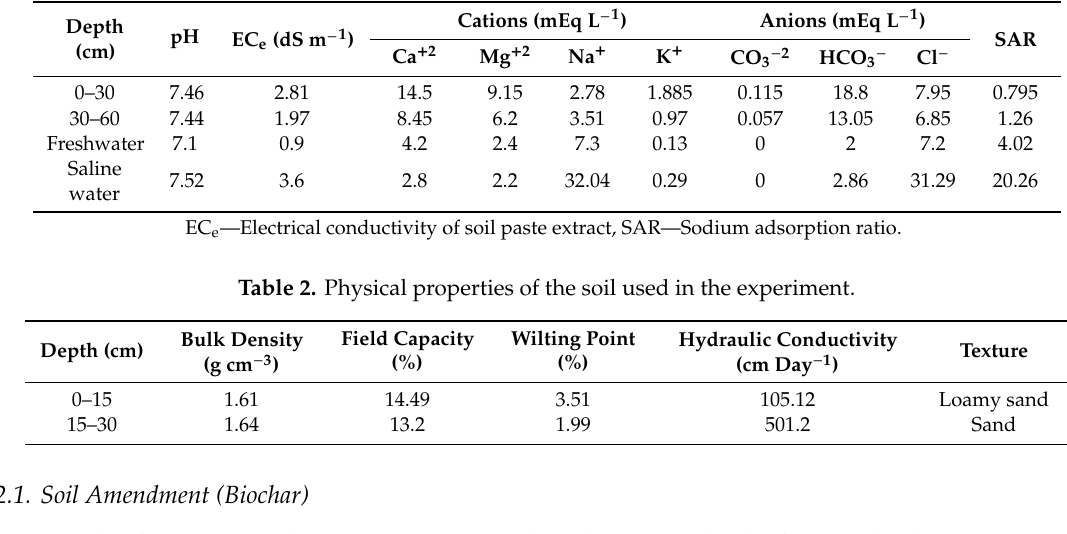
Table 1. Chemicals properties of the soil and water.